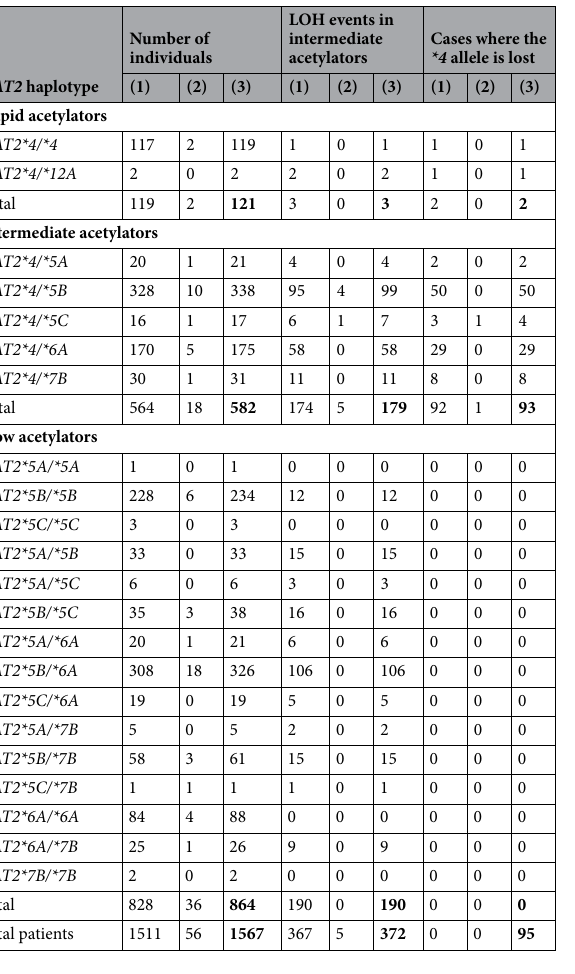
Table 1. Distribution of NAT2 genotypes and LOH events identified in tumor/normal colorectal cancer pairs in (1) Finnish cohort, (2) Swedish cohort and (3) combined data. NAT2 acetylator phenotype was called based on rs1801279, rs1041983, rs1801280, rs1799929, rs144176822, rs1799930, rs1208, rs1799931, rs2552, rs4646247, rs971473, rs45547533, rs721398 and rs721399 genotypes. Terms in bold refer to the acetylator phenotype of each tumor (rapid, intermediate or slow) given its NAT2